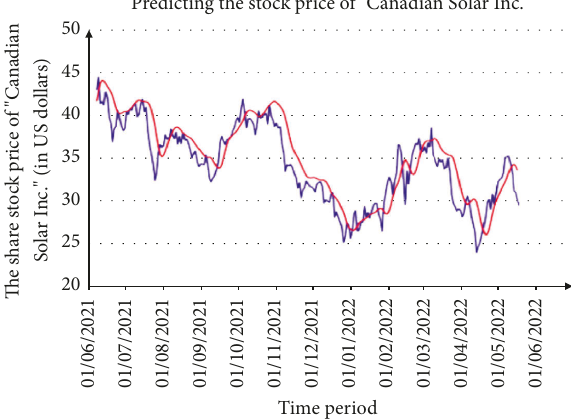
Figure 2: Predicting the stock price of Canadian Solar Inc (The blue color shows the real stock price, red color shows projected stock price). Source: